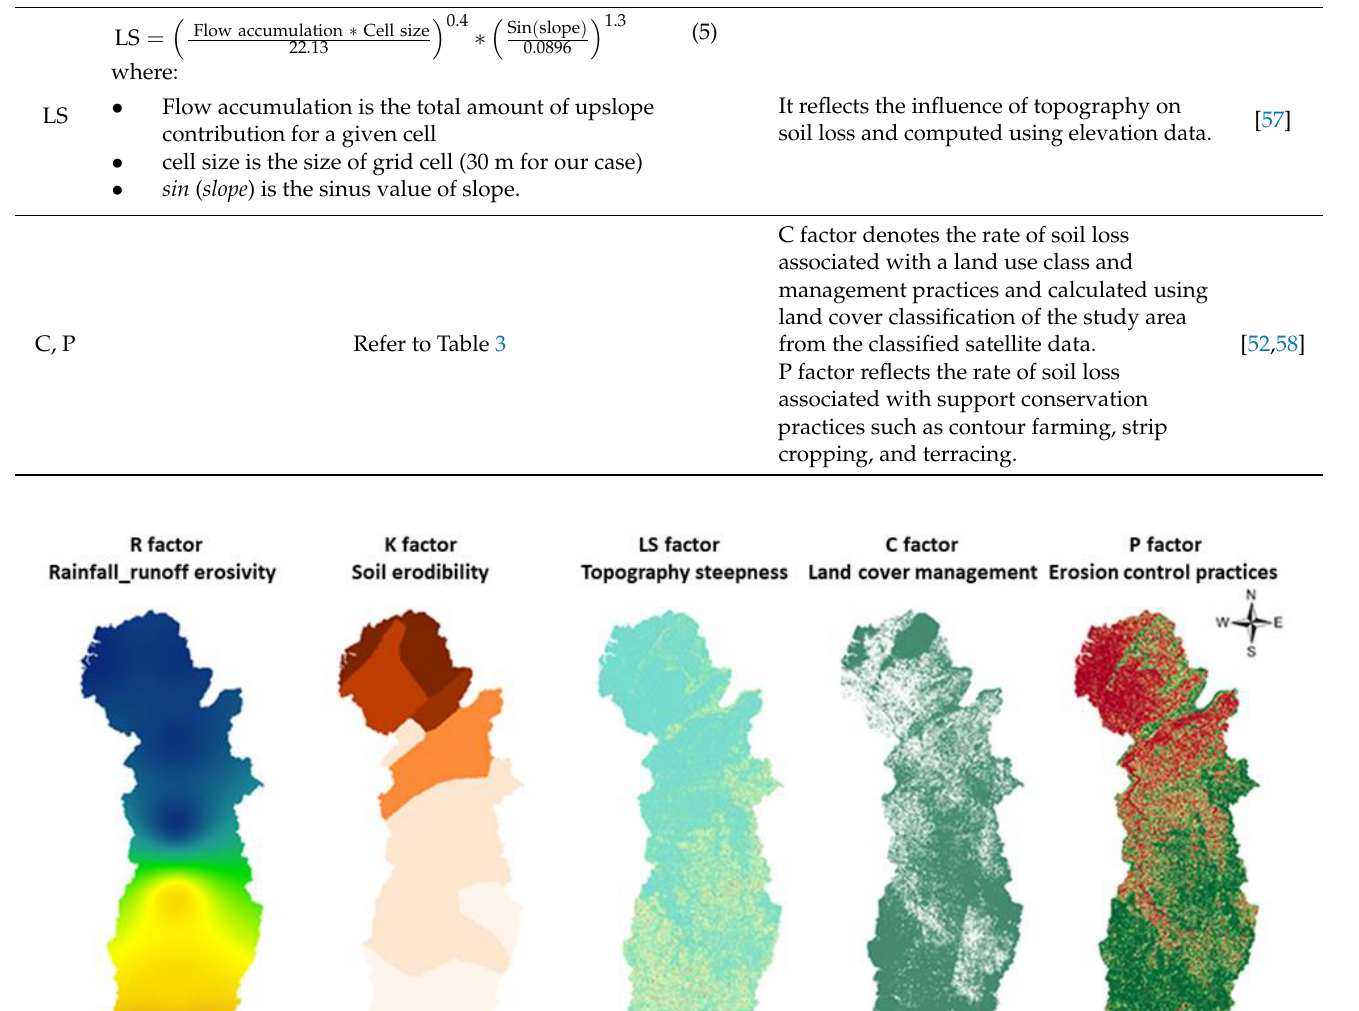
Factor Estimation of Factor Description Source